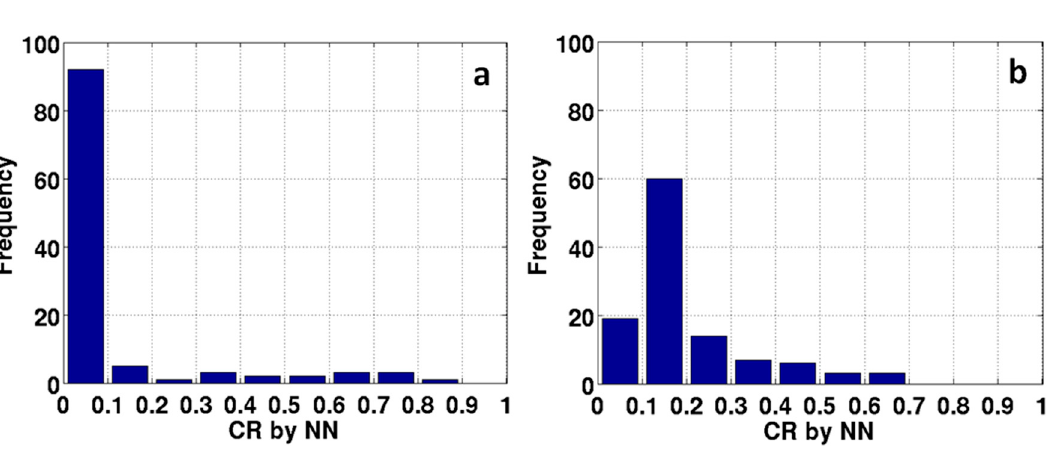
Table 2. EO data list for NN application.